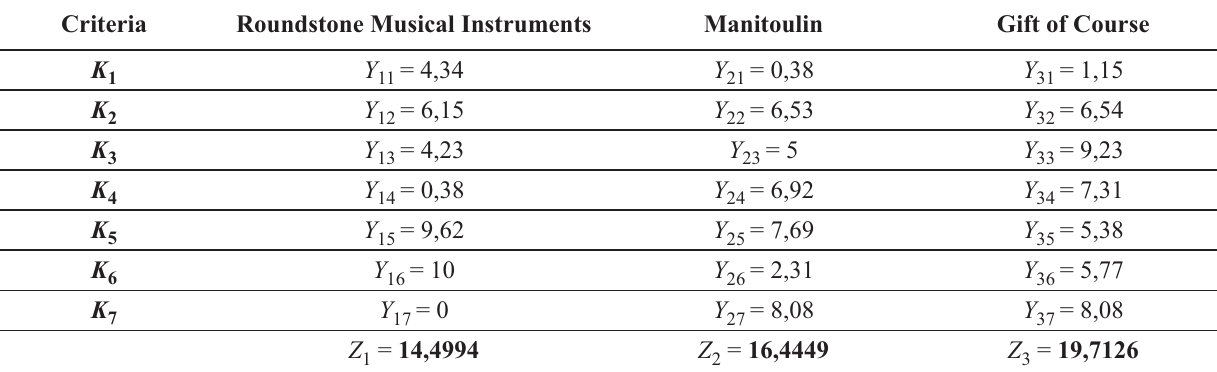
Table 5. Experimental task: project